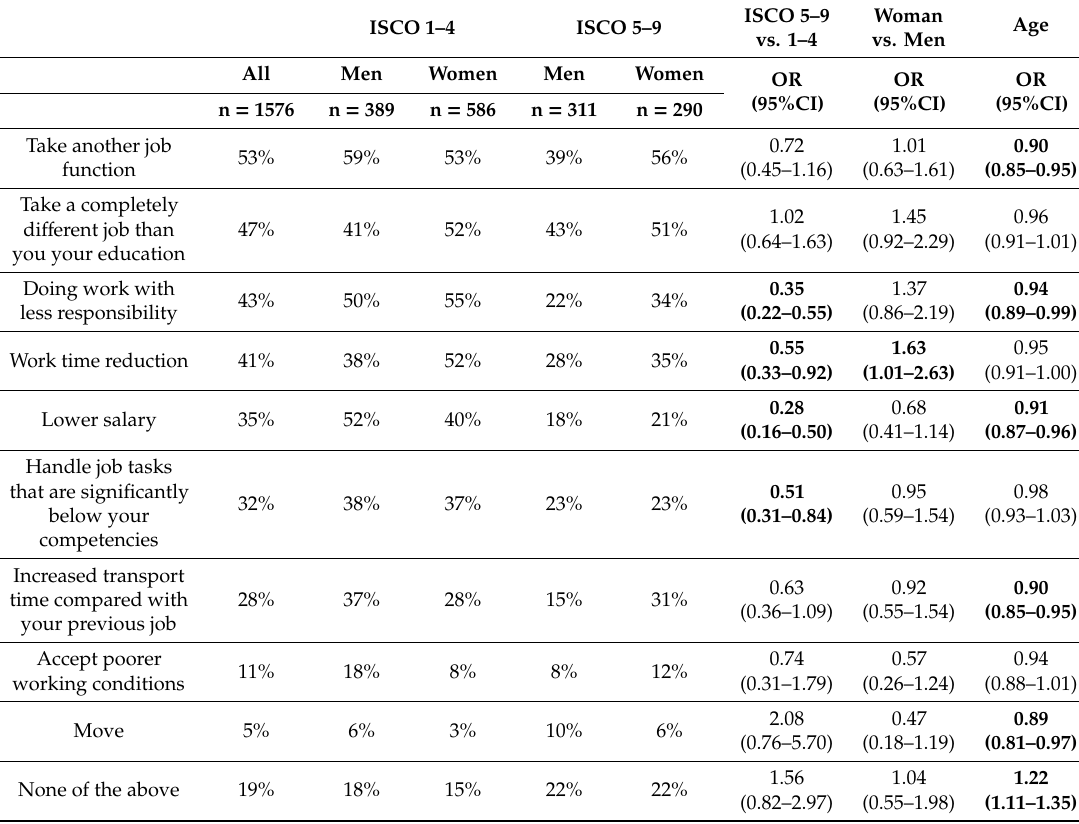
Table 3. Willingness to accept re-employment among men and women in ISCO groups 1–4 and 5–9. The first five columns are percentage of the respondents indicating this willingness, and the last three columns are OR’s and 95% CI. Significant associations are marked with